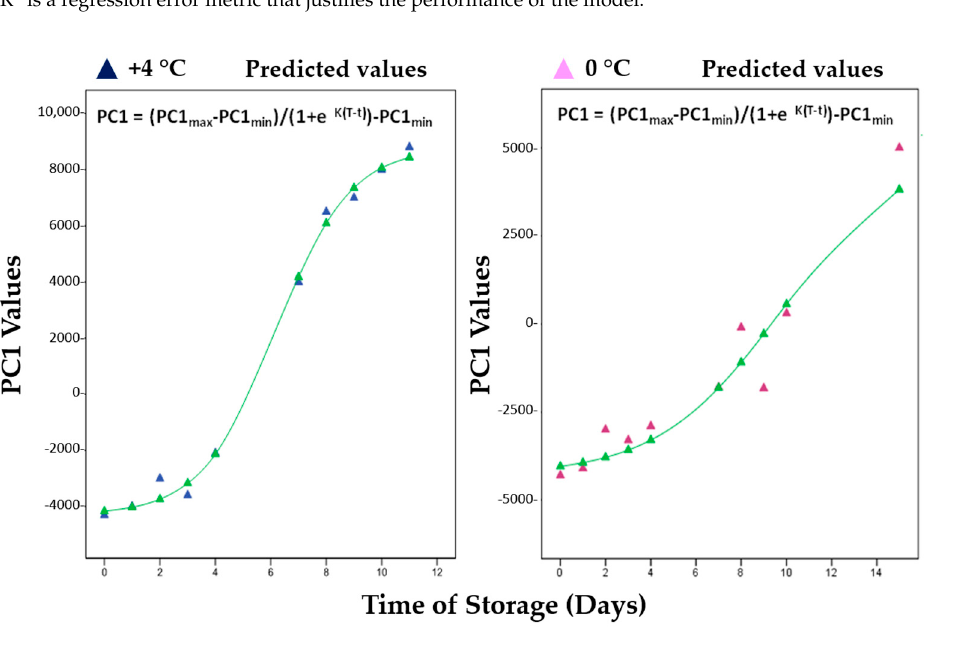
Table 2. Kinetic parameters estimated from exponential models for N-TMA concentrations and K-Index values in red mullets ( Mullus barbatus ) at +4 ◦ C and 0 ◦ C. Parameter (PC1) +4 ◦ C